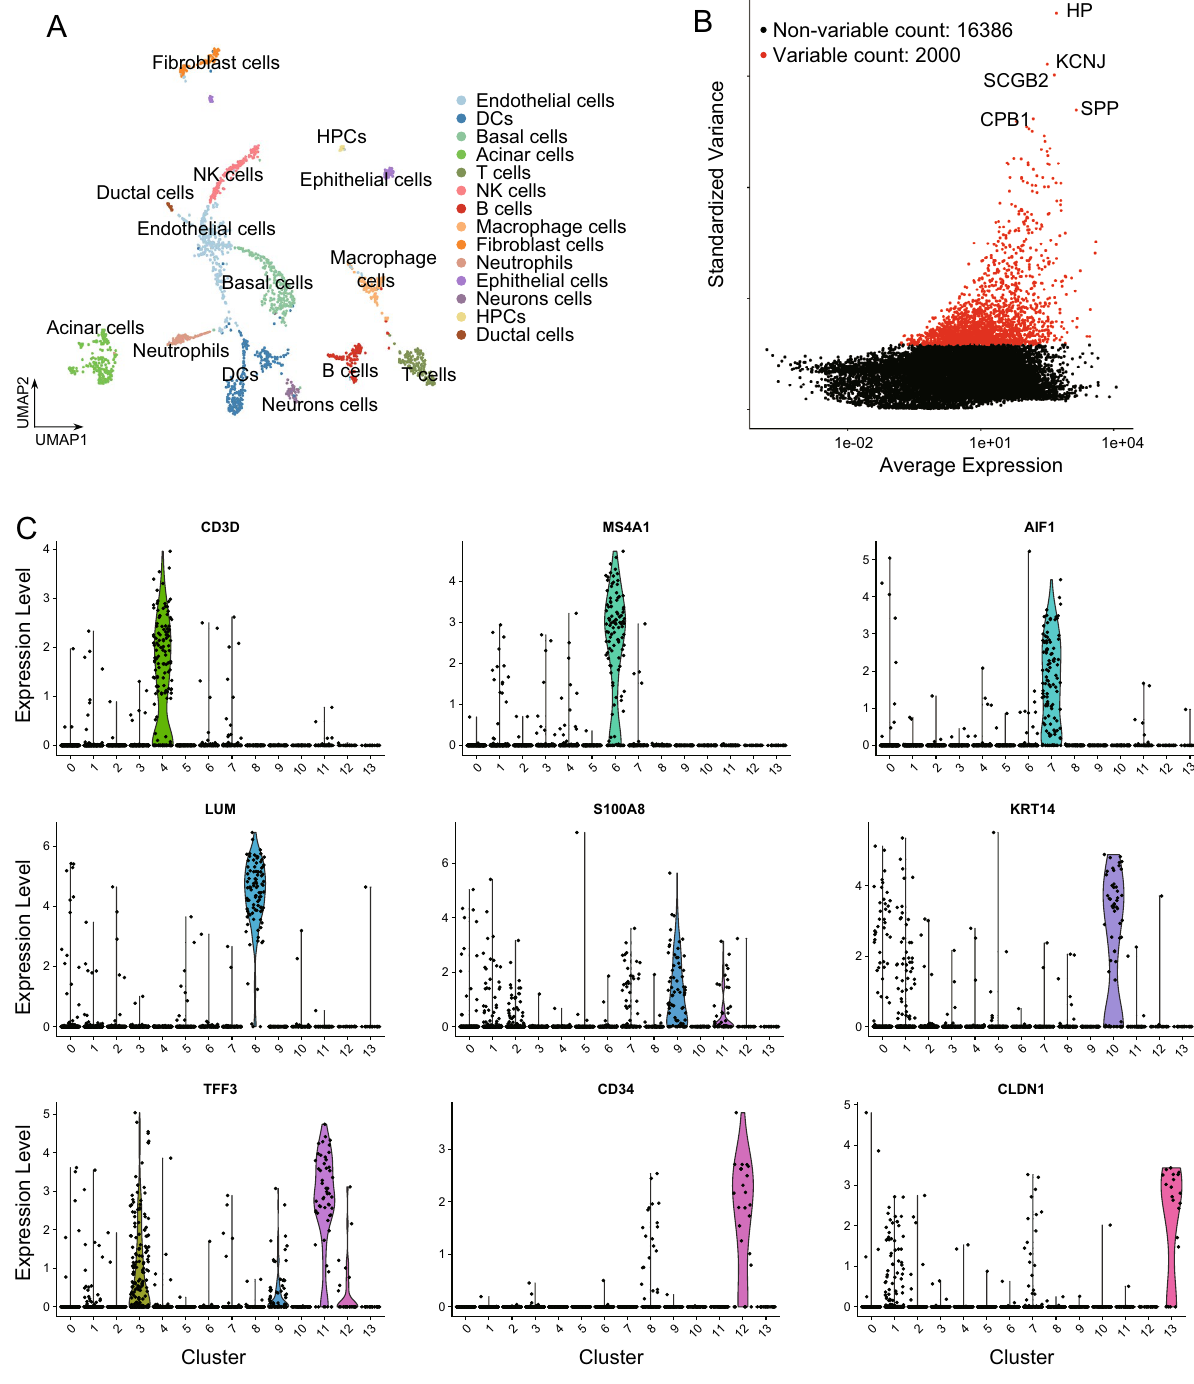
Figure 1. Single-cell clusters of breast cancer and the expression of marker genes in each cluster. ( A ) Visualization of cell UMAP clustering results. ( B ) Visualization of the genes with the highest differential variance and non-differential genes. ( C ) The violin chart shows the expression of common cell marker genes in the corresponding cell